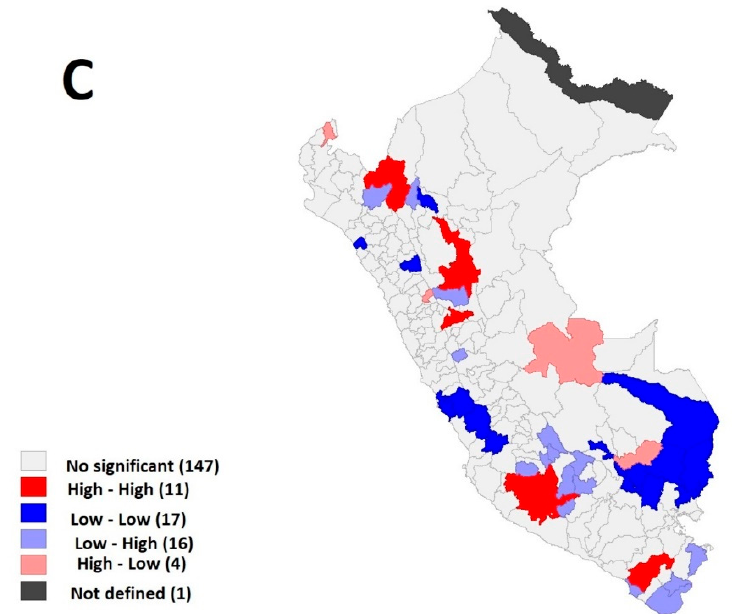
Figure 2. ( A ). Spatial analysis of provincial prevalence rates of physical violence in students of tra- ditional primary education institutions in Peru in 2019. ( B ). Spatial analysis of provincial prevalence rates of psychological violence in students of traditional primary education institutions in Peru in 2019. ( C ). Spatial analysis of the provincial prevalence of sexual violence in students of traditional primary education institutions in Peru in